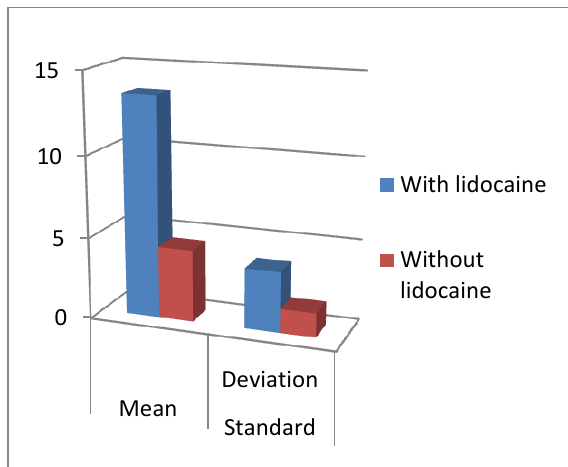
Figure 1 : Comparison of the duration of action of Suxamethonium between both